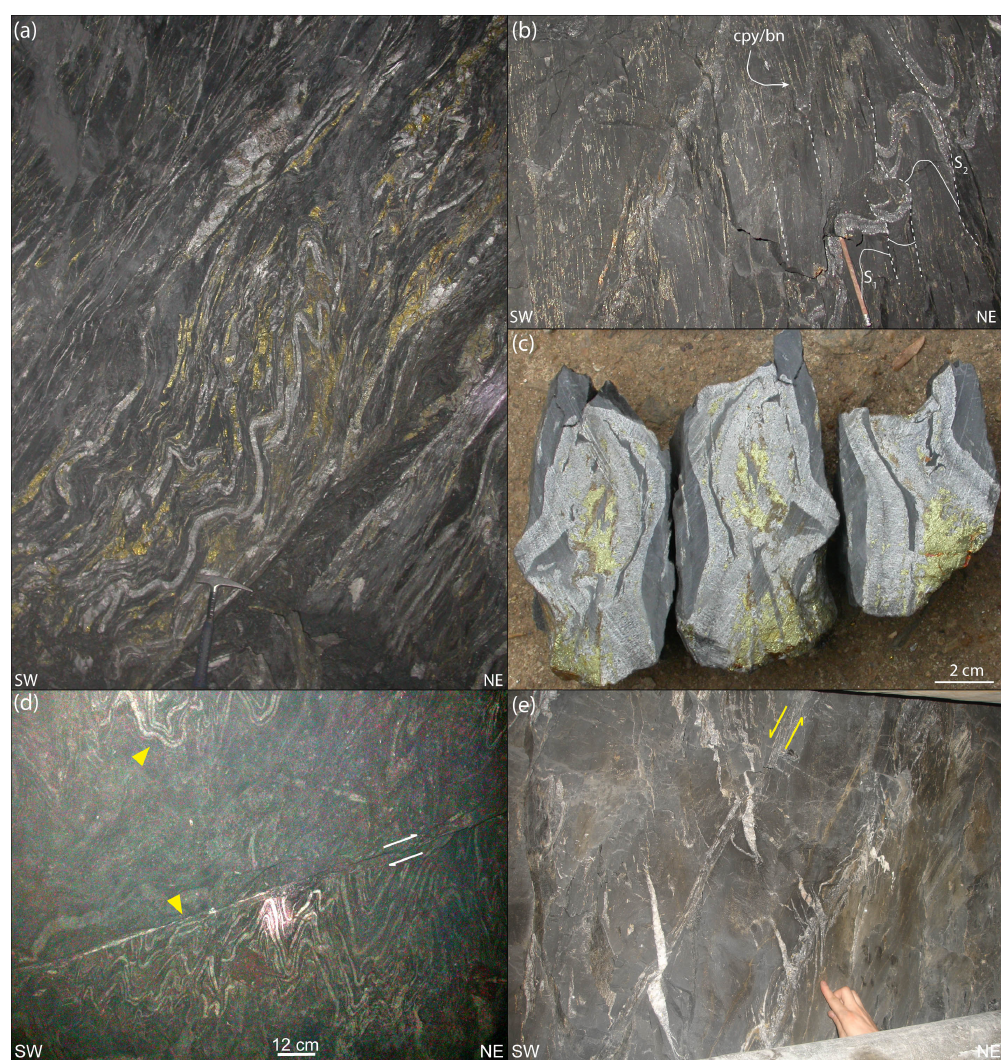
Figure 7. (a) Folded and sheared bedding-parallel veins (type I and II veins of Torremans et al., 2014). Ore mineralisation consists of pyrite, chalcopyrite and bornite in the COM and in syn-folding overgrowths. Section 11; 1230S X/C. Note distinct difference in amount of sulfides between the densely veined part and the less-veined parts, suggesting that the folding of the closely spaced competent veins provides accommodation problems and transient permeability for deposition of sulfides. (b) Subvertical disjunctive S 2 cleavage affected folded fibrous bedding-parallel veins. Abundant chalcopyrite, bornite, micas and biotite are found along S 2 . Shear slickenfibres are found along some of the S 2 planes. Section 6; 910N X/C. (c) Chalcopyrite, bornite and chalcocite in fold hinges of three parallel cuts through a sample of a fourth- order folded fibrous bedding-parallel vein. The axial plane is vertical, at 89/238, with fold limbs oriented 83/238 and 84/058. Section 10; 190S X/C. (d) Low-angle reverse fault in 16S crosscut (section 9) displacing folded bedding-parallel veins. The fault is orientated 13/203 and mineralised by dolomite and quartz. (e) High-angle normal fault with dolomite arrowhead veins in 473N crosscut at section 7 (Fig. 4). Slickenlines indicate an almost purely dip slip shear component. This fault is developed in the southern limb of a second-order anticline, with the anticlinal fold hinge towards the right of the photograph. See Supplement for detailed